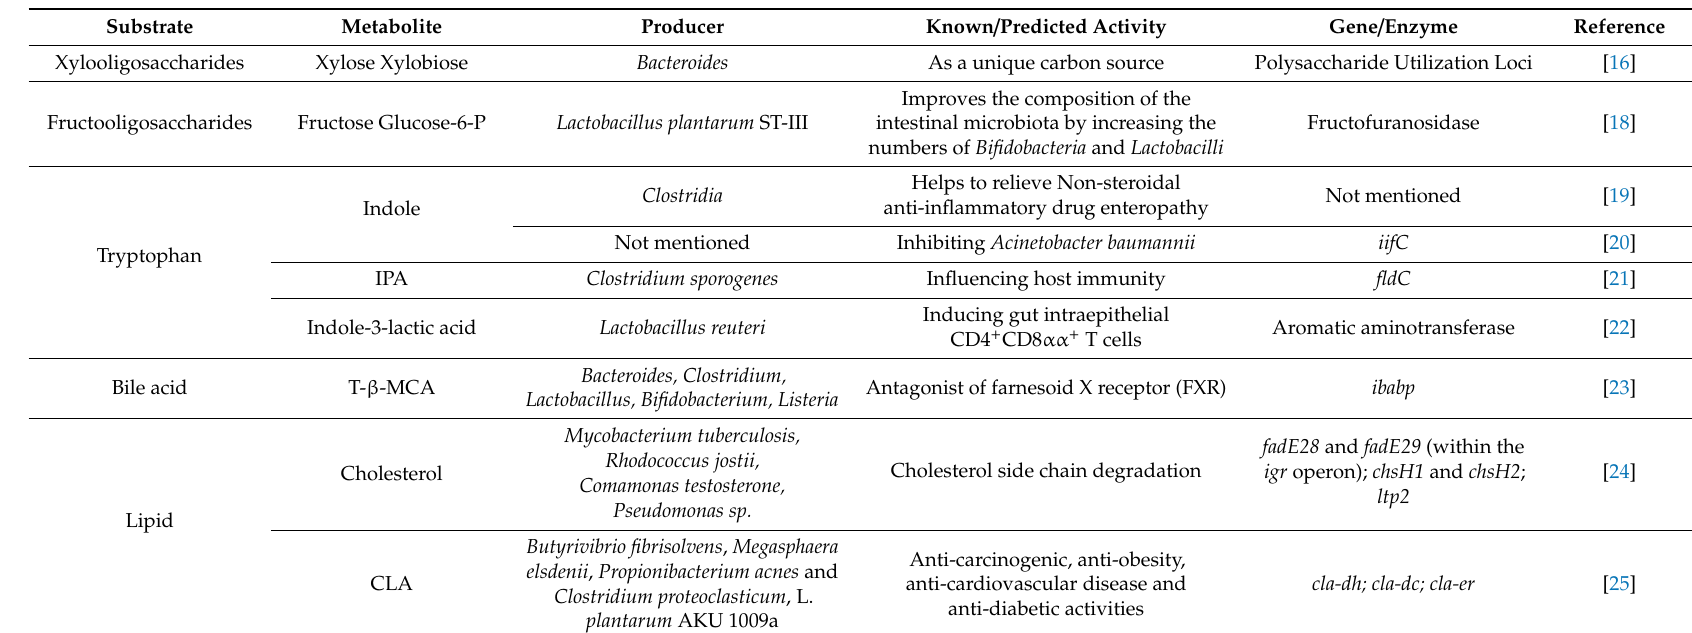
Table 1. Typical dietary substrates metabolized by gut